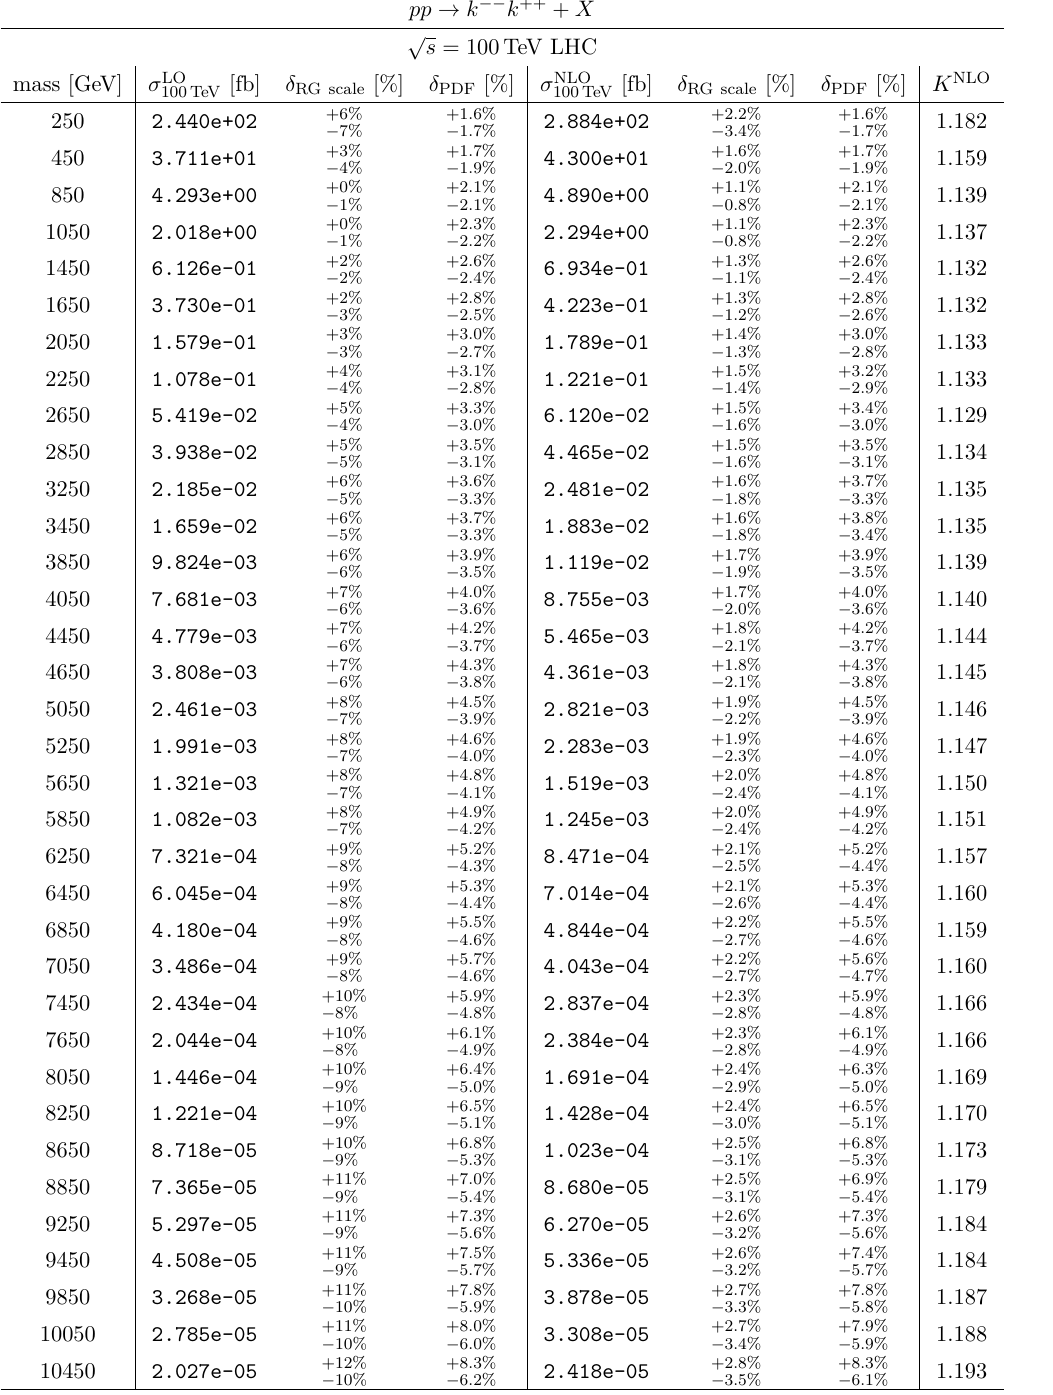
Table 10 . For representative masses m k [GeV] (first column), the predicted cross sections [fb] √ for s = 100 TeV at LO (second column) and NLO (third column) in QCD for inclusive pp → k −− k ++ + X via the Drell-Yan process (DY). Also shown are scale uncertainties [%], PDF uncertainties [%], and the QCD K -factor. See section 3.2 for SM